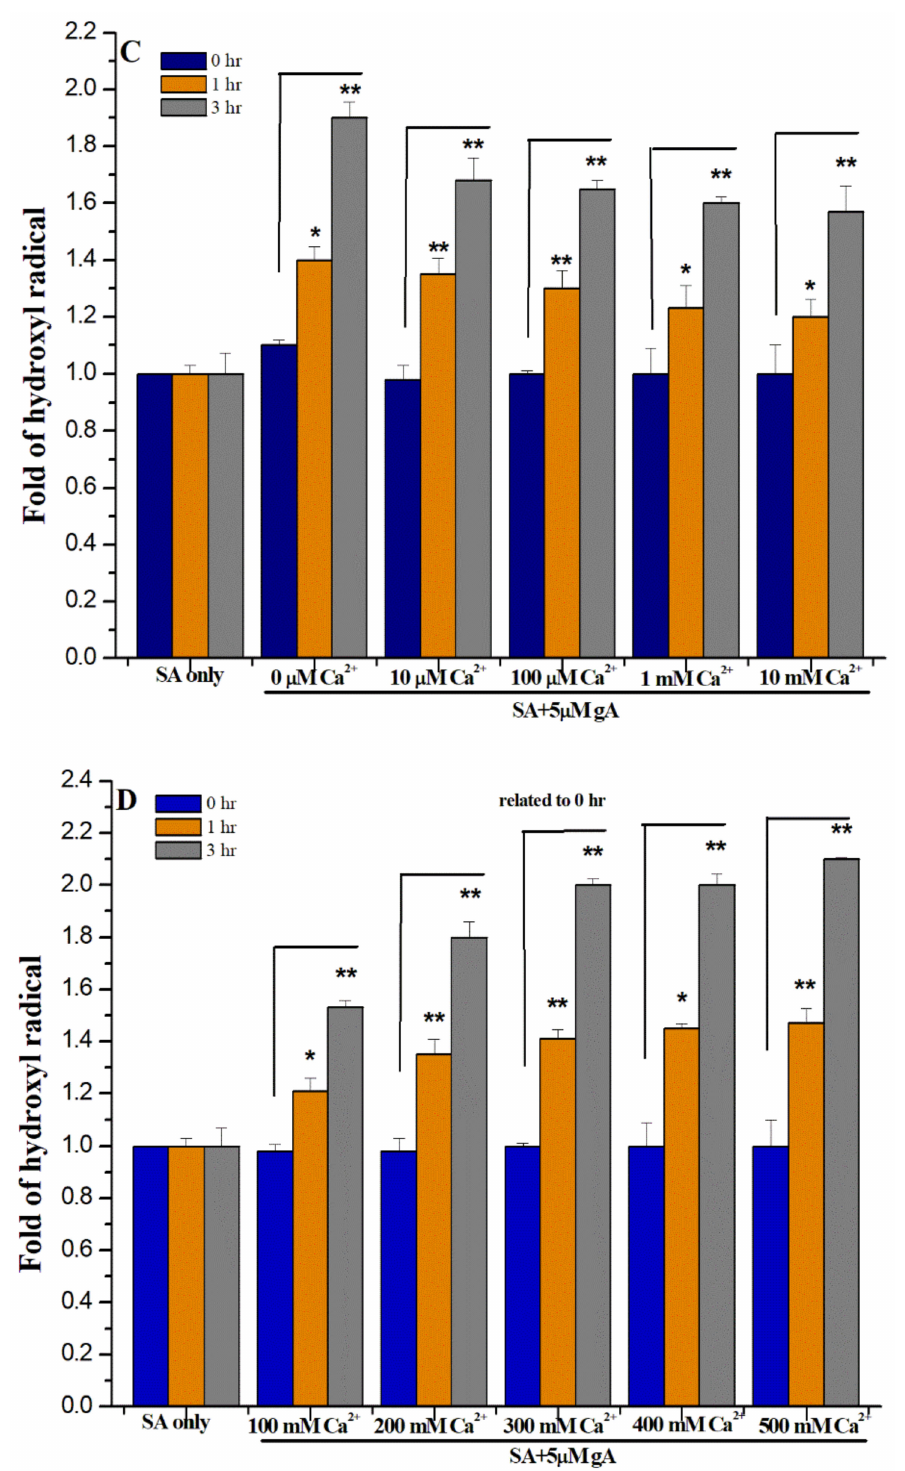
Figure 4. Hydroxyl radical level in the presence of gA and 10 µ M–500 mM of gramicidin A, ( A ) 1 µ M gA/0–10 mM of Ca 2+ ions, ( B ) 1 µ M gA/100–500 mM of Ca 2+ ions, ( C ) 5 µ M gA/0–10 mM of Ca 2+ ions, and ( D ) 5 µ M gA/100–500 mM of Ca 2+ ions, respectively. ( n = 9, ** p < 0.001, * p < 0.05). On the other hand, the effect of Ca 2+ ions on the hydroxyl free radical level with the treatment of 5 µ M gA was not as effective as that with 1 µ M gA treatment. In comparison with the treatment of 5 µ M gA only (0 µ M of Ca 2+ in Figure 4C), the hydroxyl free radical level was slightly reduced at the concentration of Ca 2+ ions ≤ 100 mM. At the